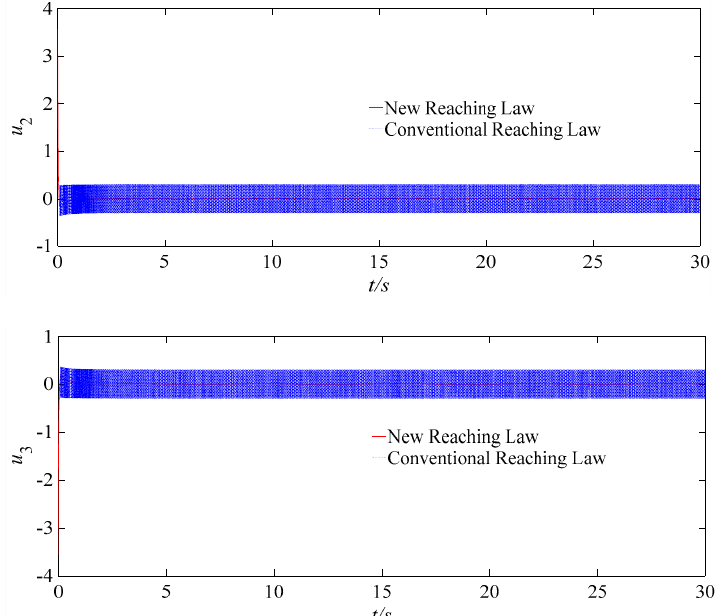
Figure 4. Responses of the controller outputs u i under the conventional reaching law and the new reaching law proposed in this paper.